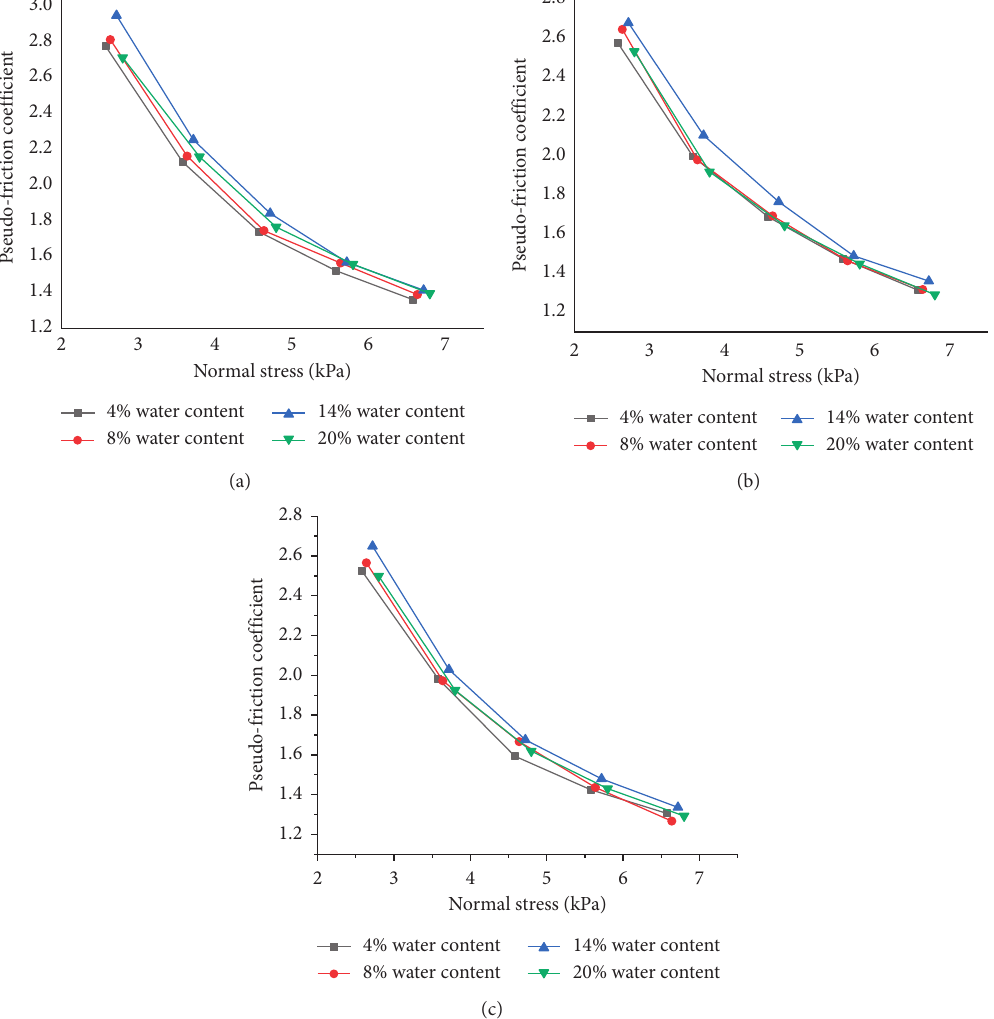
Figure 13: The apparent friction coefficient-normal stresses curve with different water content for different dry-wet cycles. (a) 0 times. (b) 7 times. (c) 30